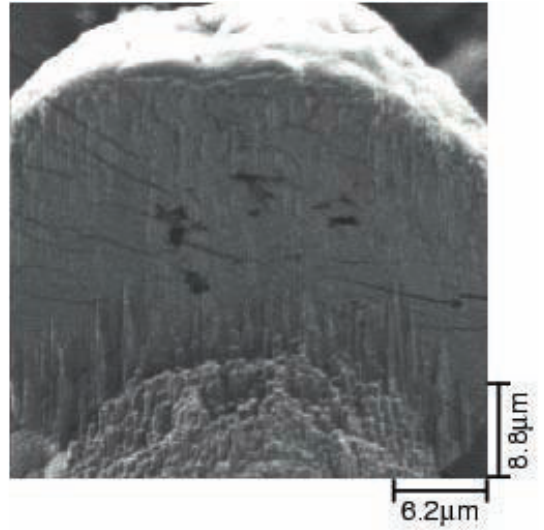
Figure 7. The cross sectional SEM image of a 30 µm par- ticle obtained in the experiment II (Humid, 95°C, A) at 24 h. The cross section was obtained by cutting the parti- cle with